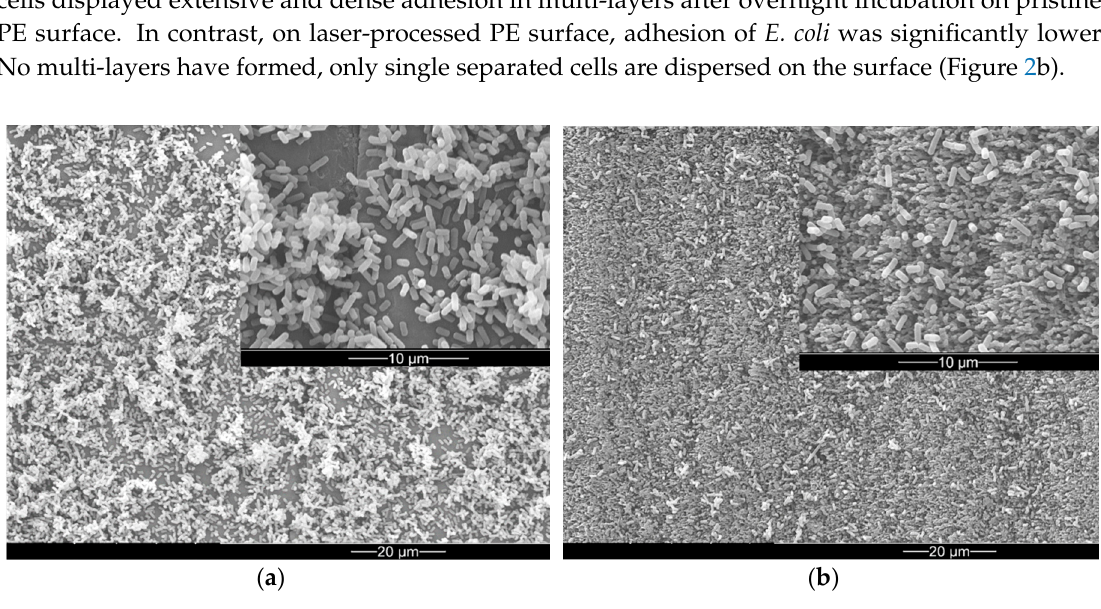
Figure 2. Environmental scanning electron micrograph (ESEM) of E. coli after 21 h co-cultivation with PE sample ( a ) on a pristine surface area ( b ) on a laser-processed surface area. The insets present high-resolution micrographs.